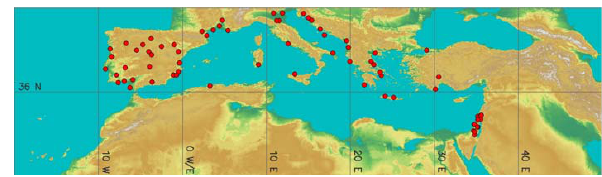
Figure 1: Location of the stations with minimum and maximum temperature data in the Fig. 1. Location of the stations with minimum and maximum tem- Mediterranean area. perature data in the Mediterranean